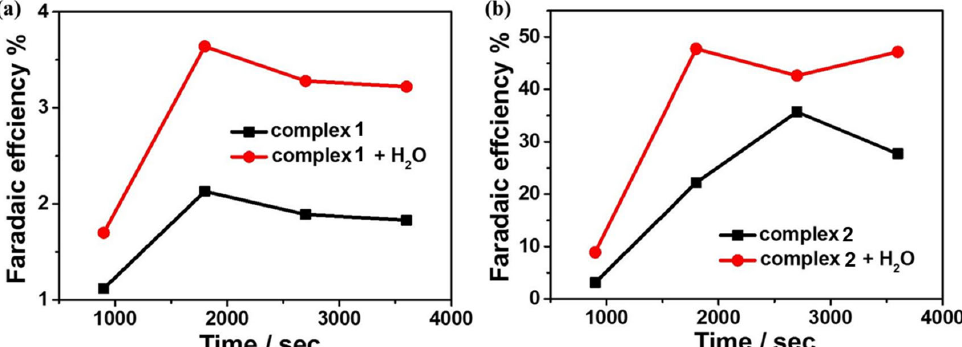
Figure 9. ( a ) Faraday efficiency of carbon monoxide produced by 0.5 mM complex 1 in the pres ‐ ence/absence of H 2 O in DMF solution; ( b ) Faraday efficiency of carbon monoxide produced by 0.5 mM complex 2 in the presence/absence of H 2 O in DMF solution.